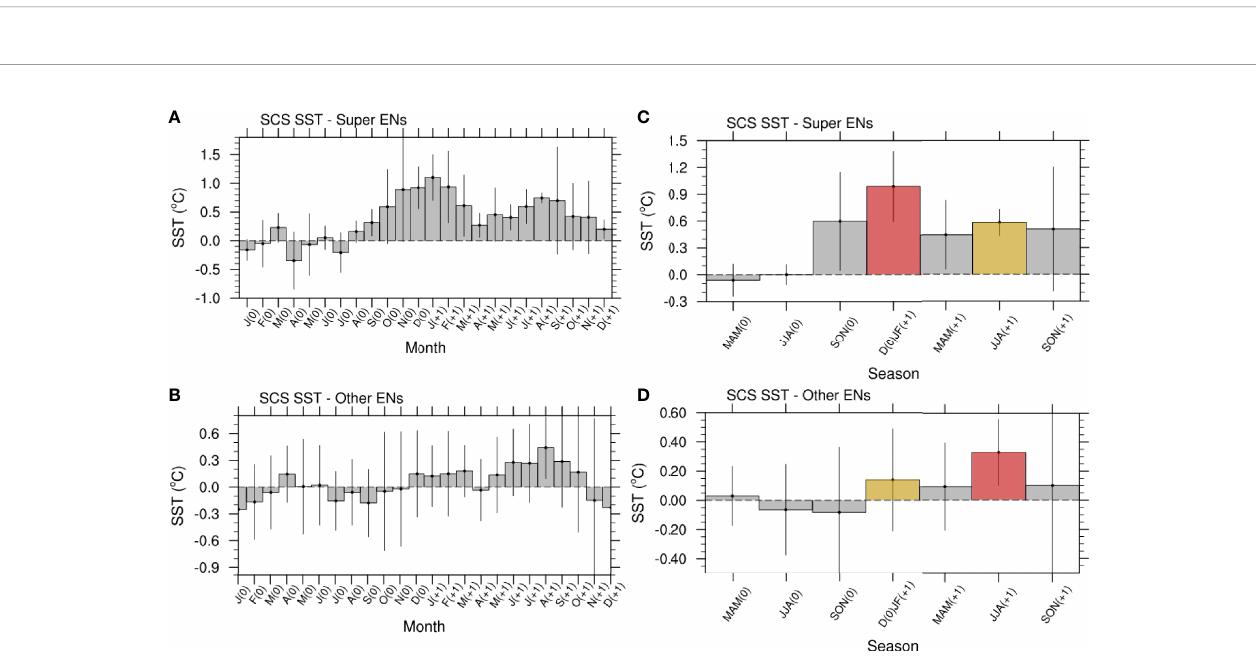
FIGURE 2 | (A) . Gray bars indicate two-year SST anomaly evolutions averaged over the SCS (10 – 20°N, 109 – 118°E) for super El Niño composite and the error bars indicate ±1 standard deviations of every month. (B) Same as in (A) but for the other El Niño composite. (C, D) Same as in (A, B) but for the seasonal mean. The red shading and yellow shading in (C, D) indicate the warming peaks, and the red one is the